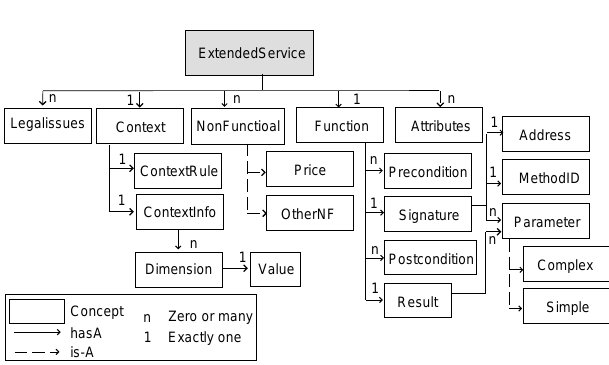
Figure 3. ExtendedService